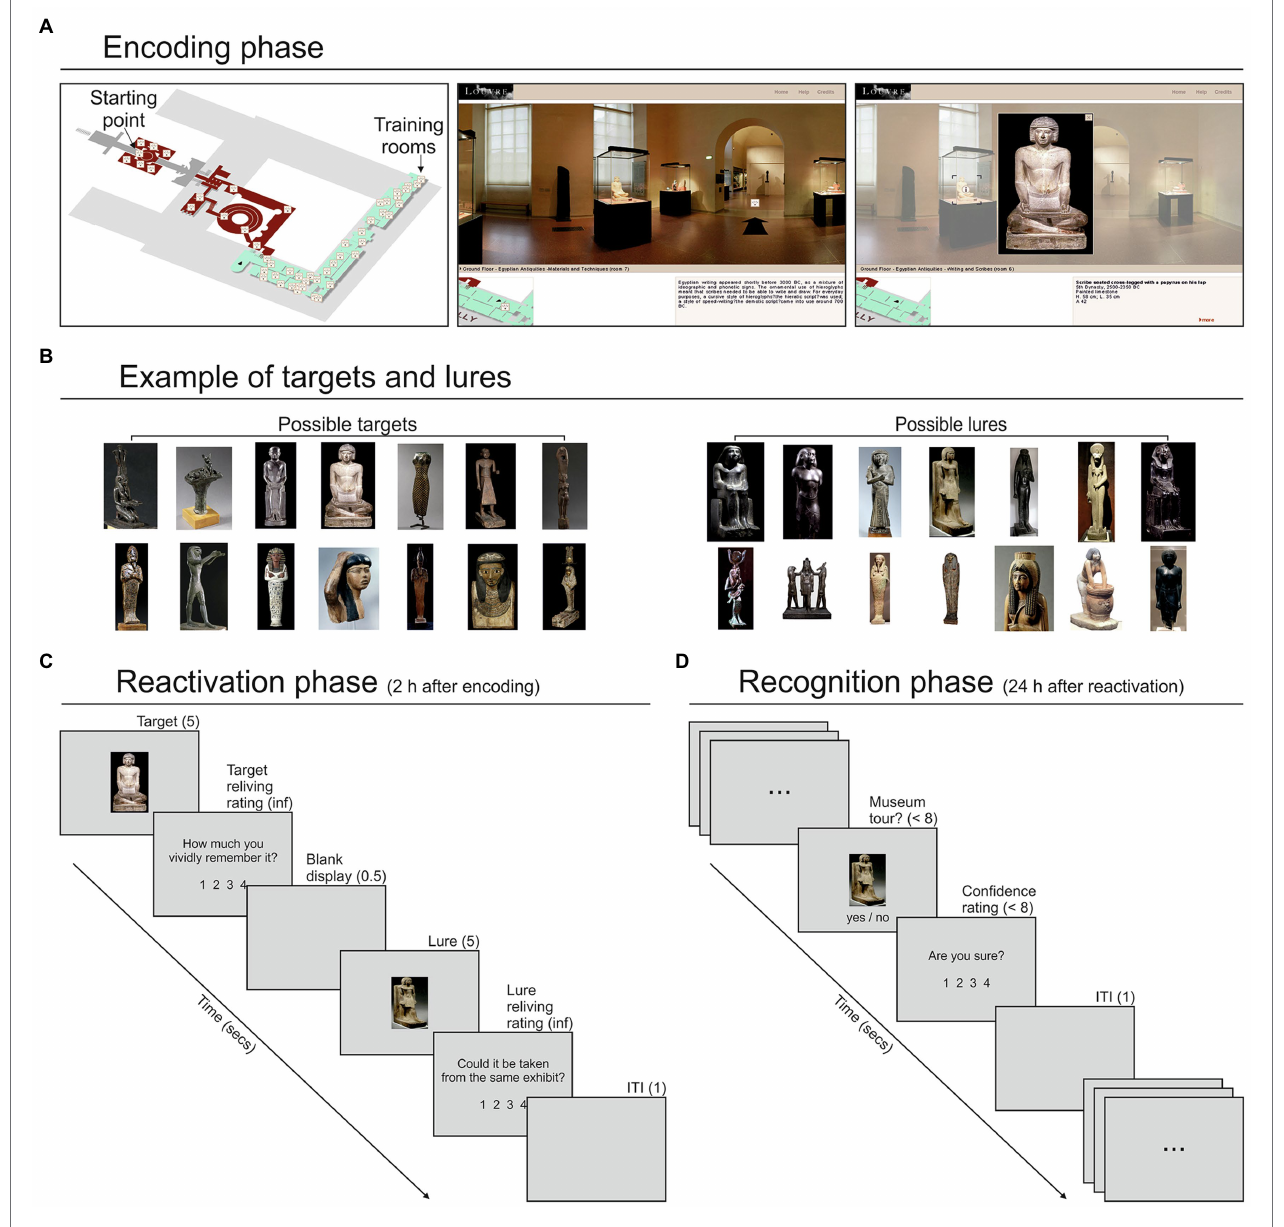
FIGURE 1 | Virtual tour display and artworks examples. (A) Left panel: map of the explorable rooms of the Egyptian (in green) and Historic (in red) galleries of the Louvre Museum; middle panel: example of the view during the tour, including the display of a museum room, the position of the room in the map (bottom-left corner) and a brief description of the room (bottom-right corner); right panel: example of the close-up view of a clickable artwork—revealed by a circled “i” symbol (i.e., “information”) when moving the mouse—selected by the participant. (B) Targets and lures related to an example category, that is, “statuettes.” (C) Example of a trial of the memory reactivation phase that started 2 h after the end of the encoding phase. Each trial started with the presentation of a target object (i.e., an artwork explored in the encoding phase) for 5 s, and a following reliving rating; then, after a blank display of 0.5 s, a lure object, belonging to the same category of the target, was presented for 5 s, followed by a relatedness rating. (D) Example of a trial of the memory recognition phase that started 24 h after the reactivation phase. Each trial consisted in the presentation of an artwork. The participants judged whether this artwork was encountered during the virtual tour or not and then provided a confidence judgment. For each response, they had a maximum time of 8 s. ITI, inter-trial